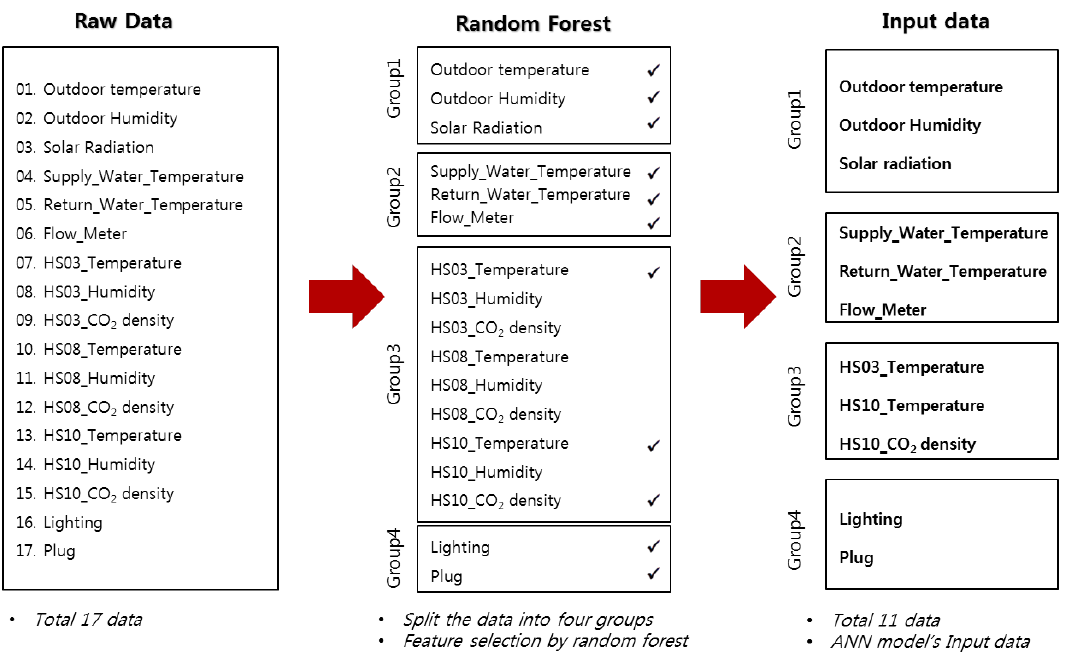
Figure 9. Results of feature selection by random forest.